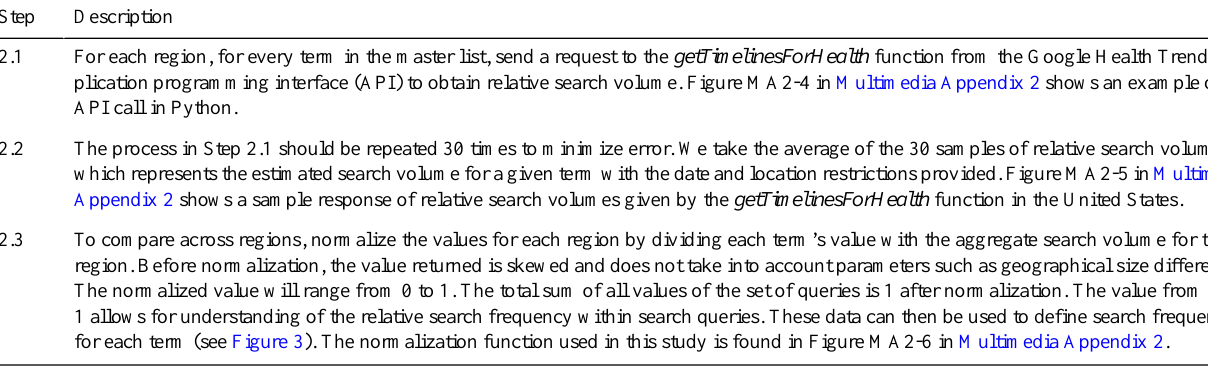
Table 2. Gathering information on search